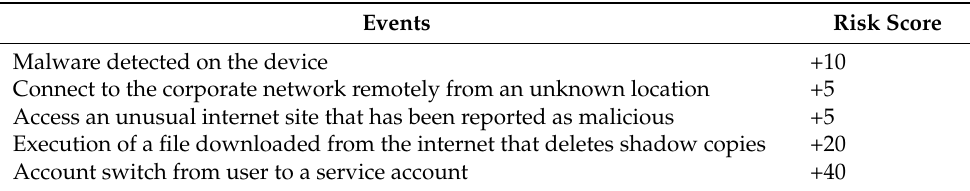
Table 1. Example of risk score based on security